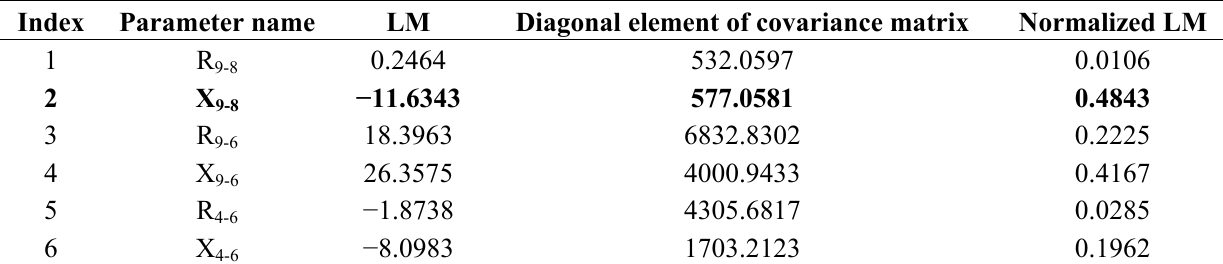
Table 2. Detail results of the PEI in a 9-node